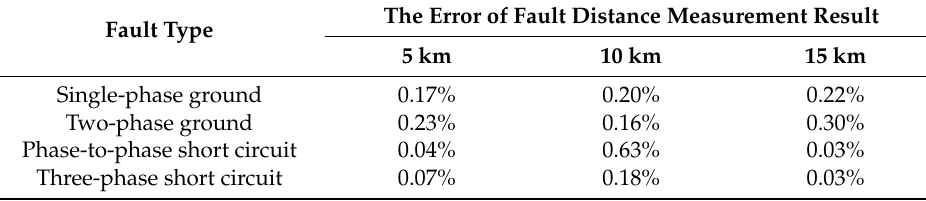
Table 1. Performance of the time-domain method when faults